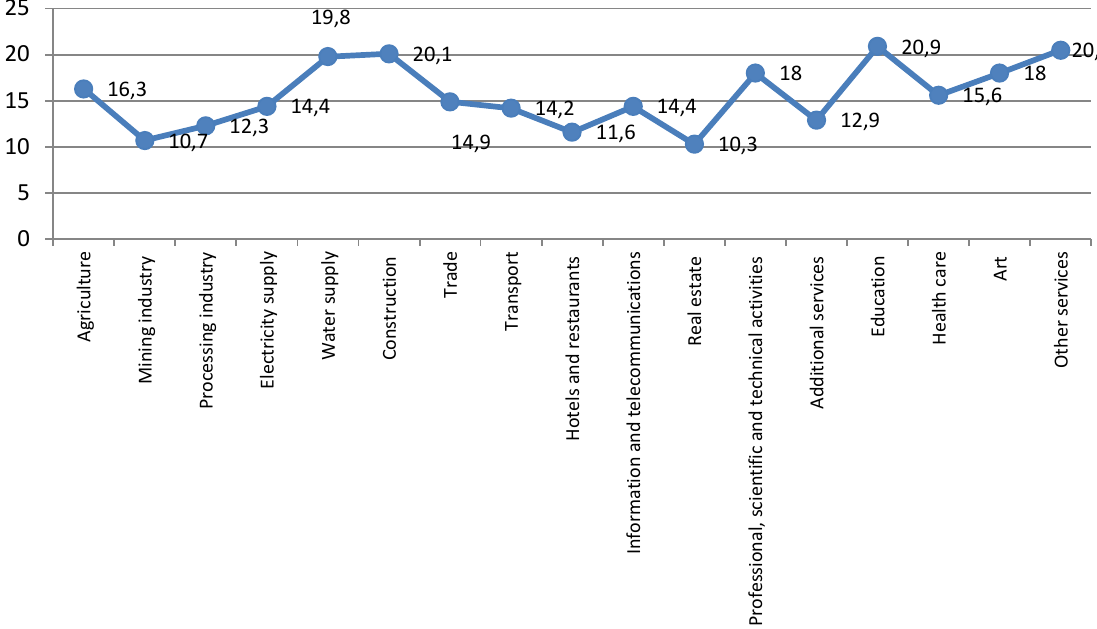
Figure 2. Weighted annual average rates on loans by industries in Ukraine in 2017, %